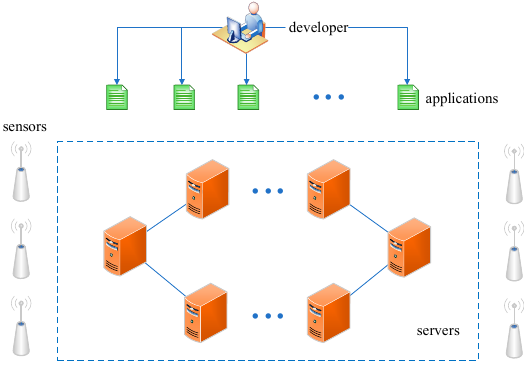
Figure 3. A distributed execution environment.